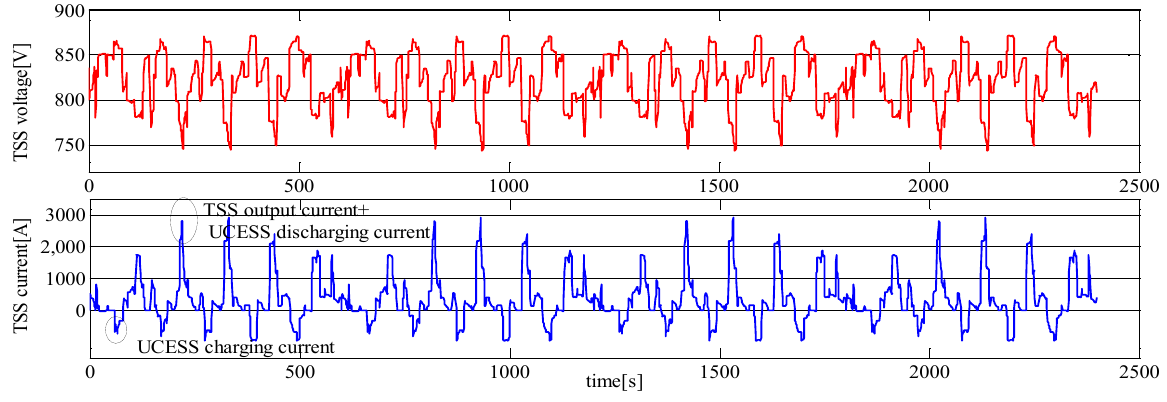
Figure 12. ESS charging/discharging power and